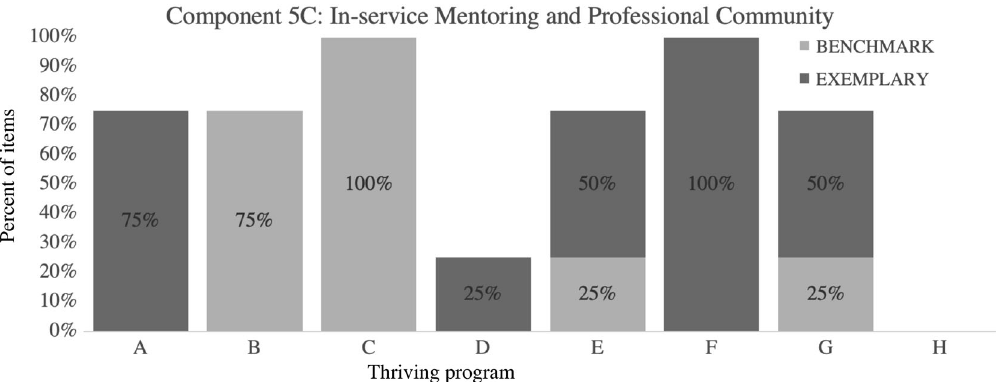
FIG. 6. Percent of items in component 5C rated at benchmark level (light gray) or exemplary level (dark gray) at each of the studied programs (A – H). Percentages are out of the number of items in component 5C, which is